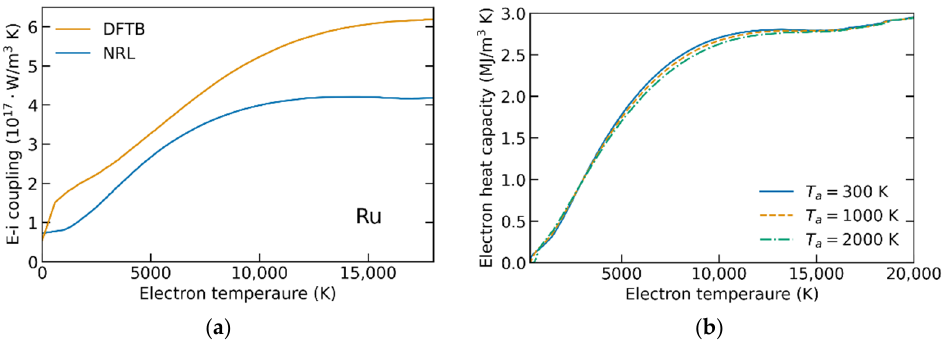
Figure 1. ( a ) Electron–ion couplings G(T e ) in ruthenium calculated using NRL and DFTB parametri- zations. ( b ) Electron heat capacity in ruthenium calculated for different atomic temperatures.